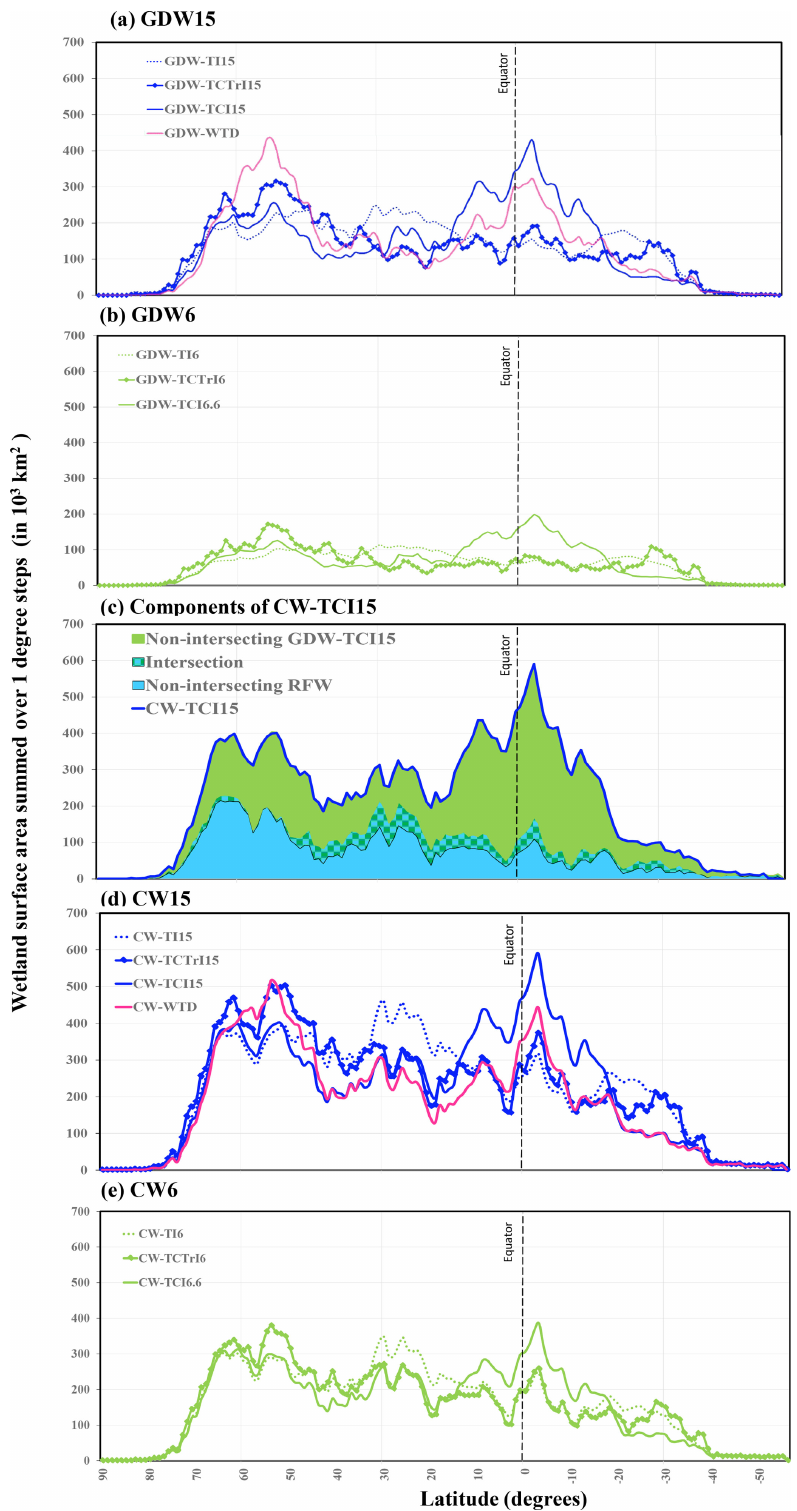
Figure 3. Latitudinal distribution of different wetland maps: (a, b) GDWs, (c) components of CW-TCI15 and their intersection and (d, e) CWs. The wetland areas along the y axis are surface areas in each 1 ◦ latitudinal band.